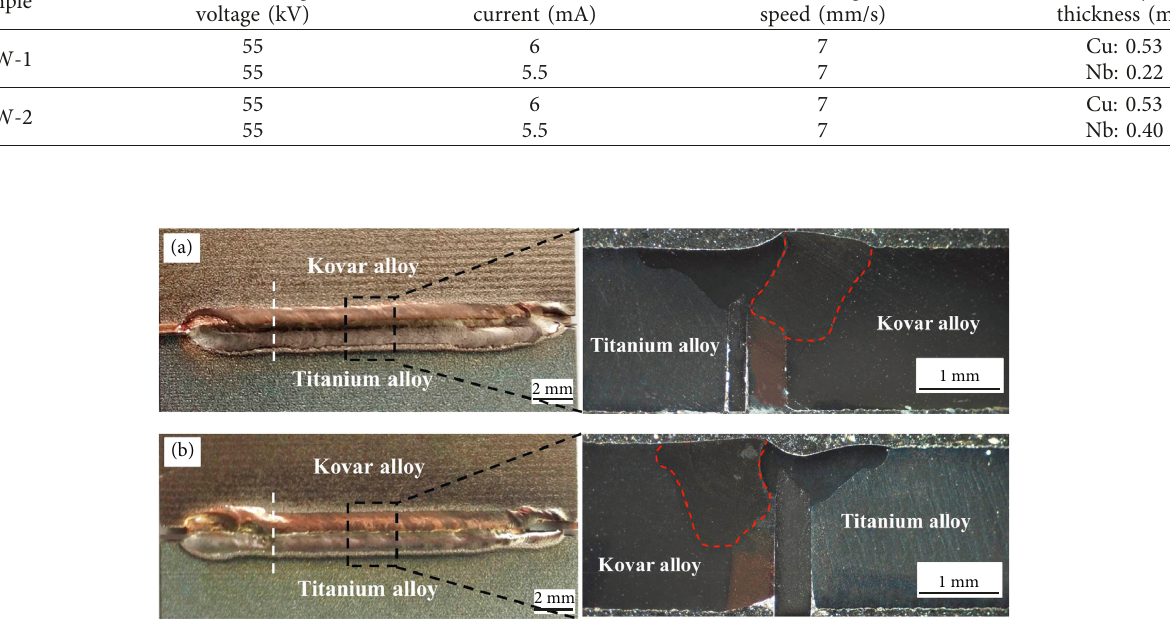
Figure 2: Surface appearance and the cross sections of welds: (a) EBW-1 with 0.53mm Cu and 0.22 mm Nb; (b) EBW-2 with 0.53mm Cu and 0.40mm Nb.